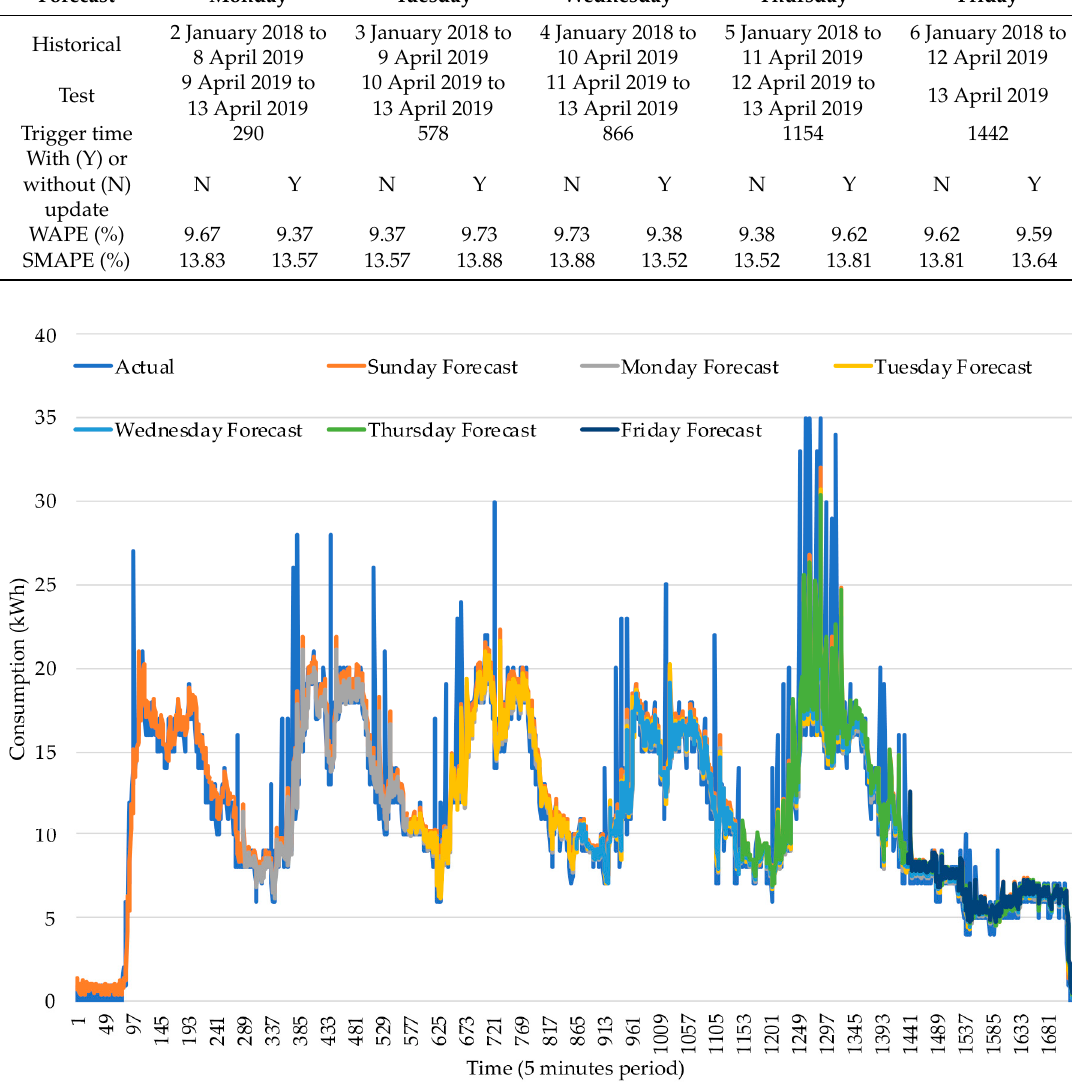
Figure 8. Consumption forecast errors for period 8 to 13 April 2019.